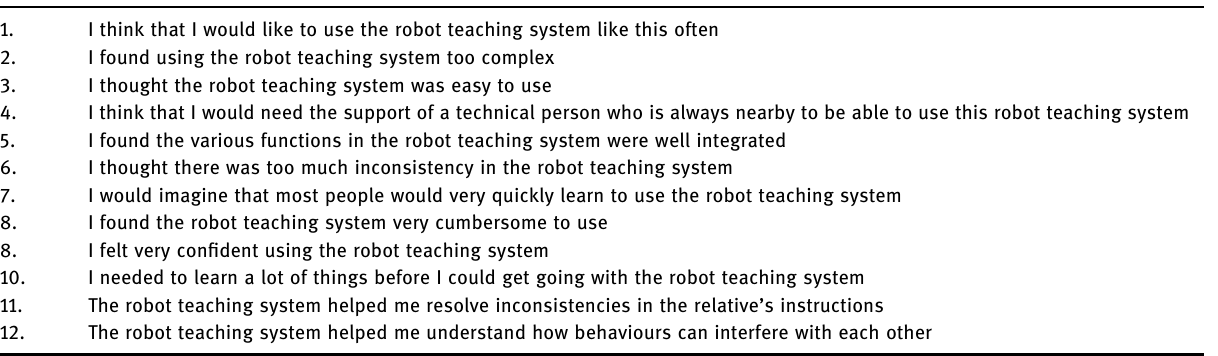
Table 2: Usability Questionnaire used in the present study Modi fi ed Brooke ’ s Usability Scale ( 5 point Likert scale ) , items 1 – 10, complemented by 2 additional items